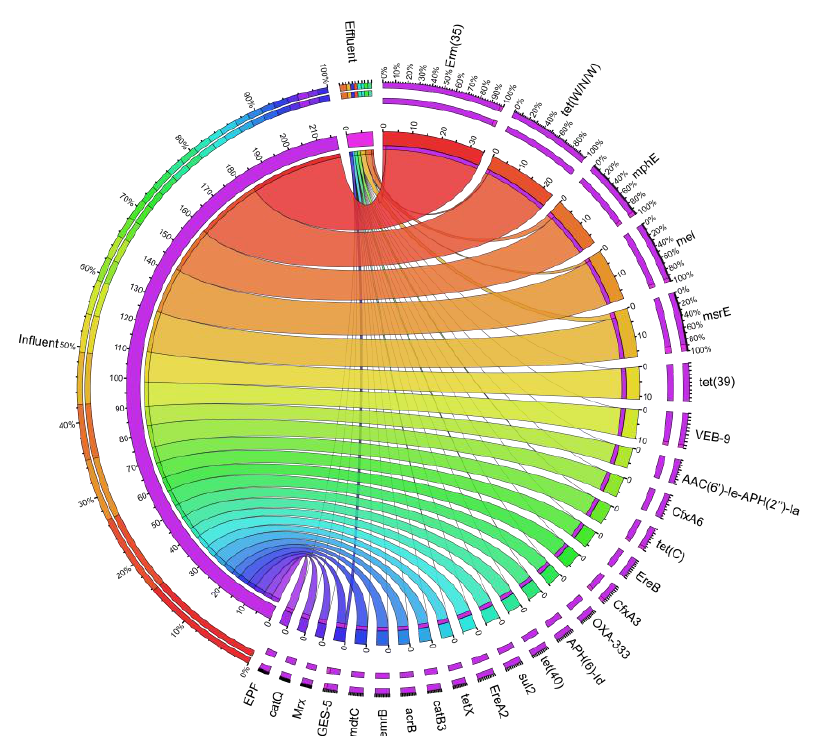
Figure 4. The distribution structure of ARG subtypes (relative abundance > 1%) in the influent and effluent samples, visualized by Circos software. The names of influent and effluent samples and ARG subtypes are listed in the outside circle. The connecting lines within the circles relate the ARG subtypes to the sample, and the width of each line indicates the abundance of each ARG subtype in the influent and effluent samples. The color of each line was used to distinguish the association between the sample and the ARG subtypes.